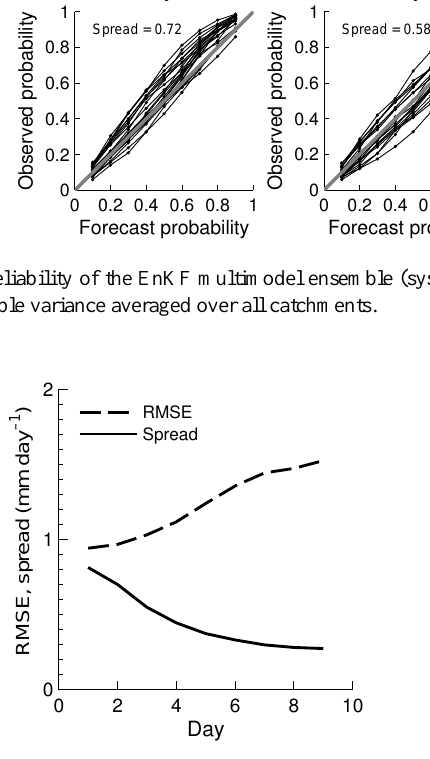
Figure 7. Typical spread skill plot of a single model EnKF ensem-